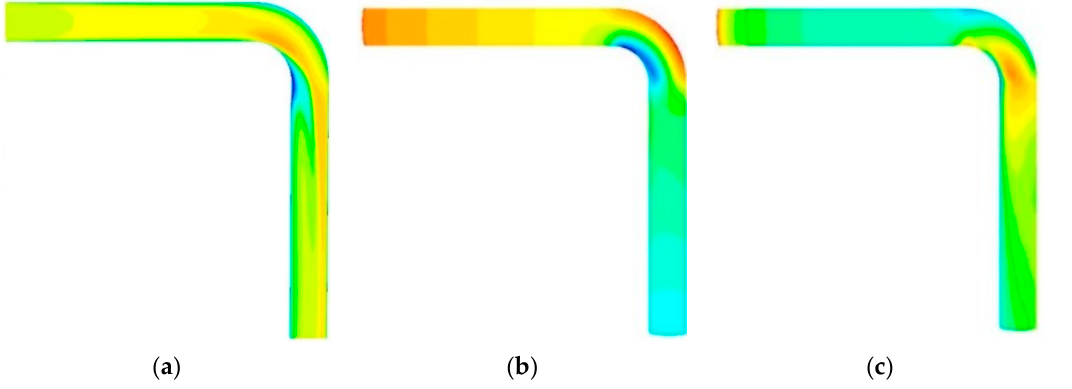
Figure 6. Calculation results of numerical simulation method; ( a ) Velocity cloud; ( b ) Pressure cloud; ( c ) Wall shear stress cloud.